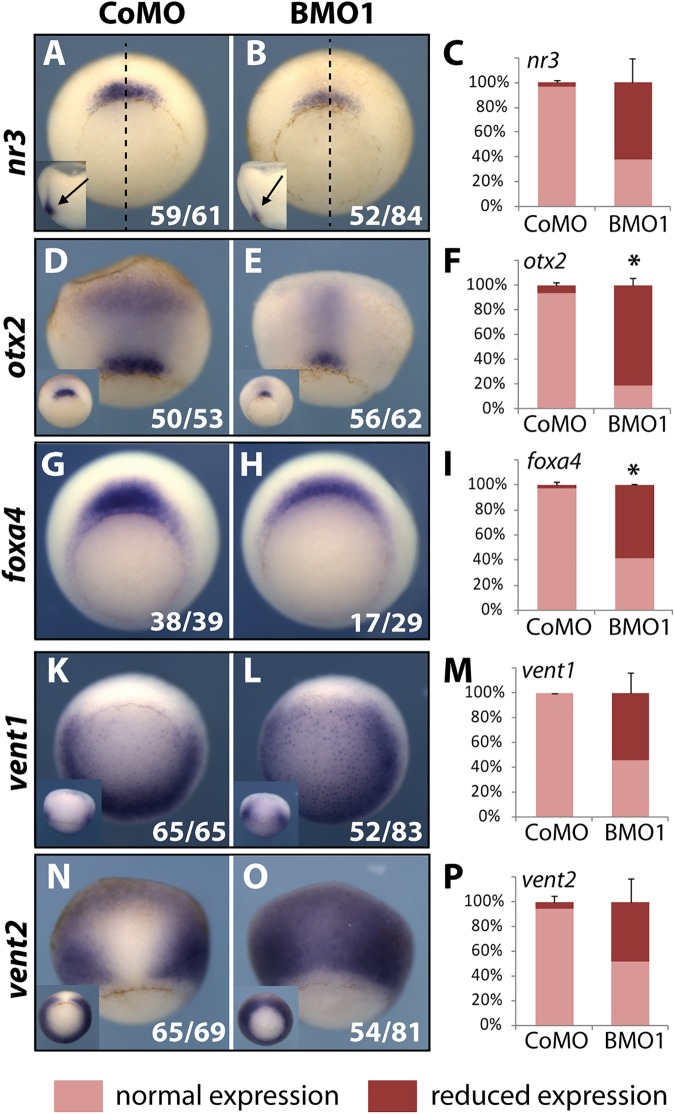
Reduced Brg1 protein levels impair organizer function.X. laevis embryos were radially injected with 40ng of indicated MOs and fixed at early. Representative images of the predominant morphant expression patterns are shown by WMISH in vegetal (A, B, G-L) or dorsal (D, E, N, O) side views. The Organizer region is represented by nr3 (A-C), otx2 (D-F) and foxA4 (G-I). Inserts depict deep staining in bisected embryos for nr3 or blastopore lip staining for otx2. Non-organizer mesoderm is represented by the BMP target genes vent1 (K M) and vent2 (N-P). Inserts show side views for vent1 and vegetal views for vent2 (n = 2-4 independent experiments/gene).